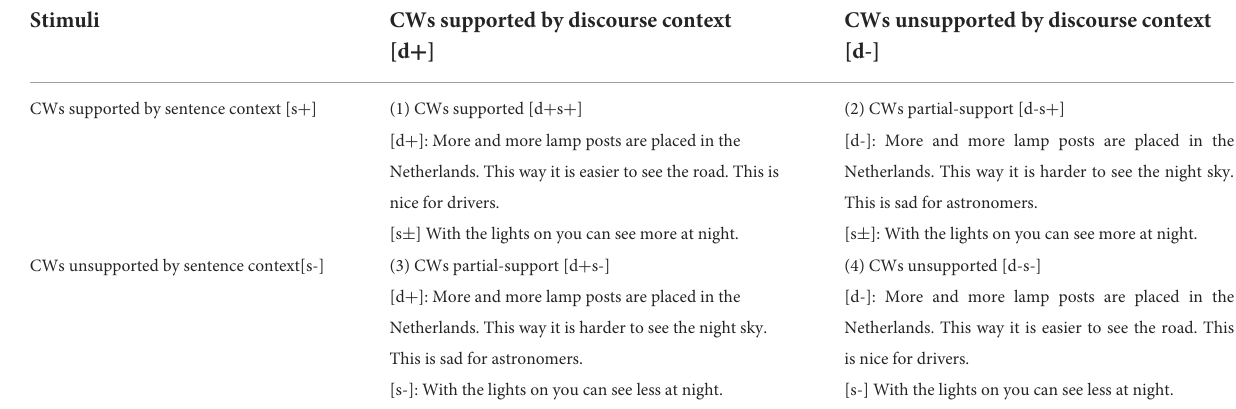
TABLE 1 Example